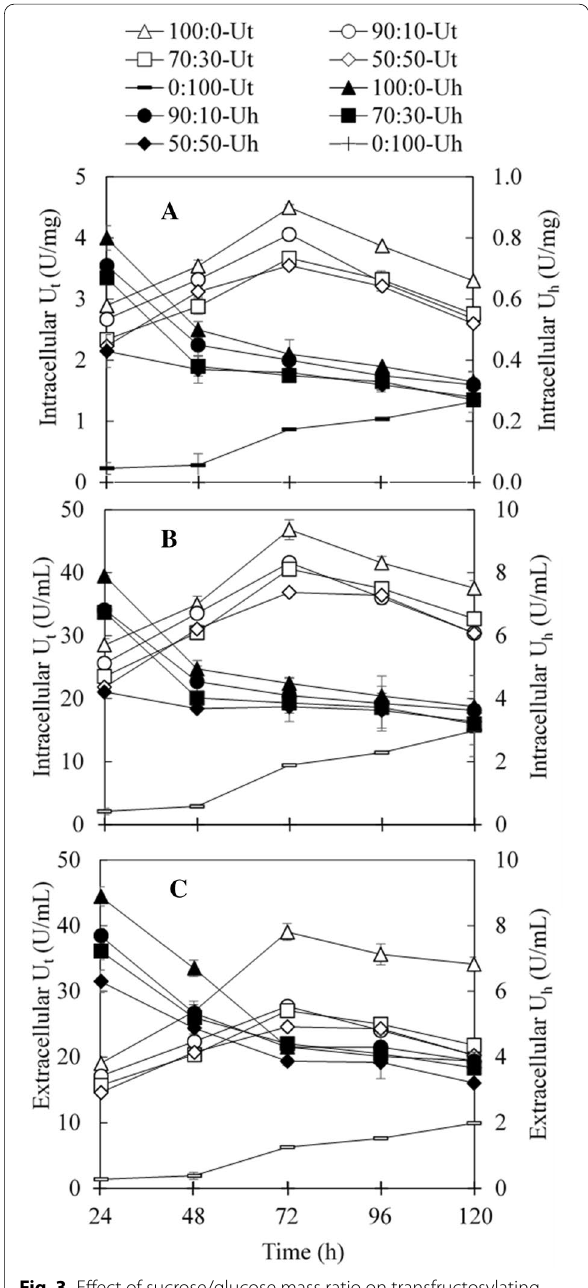
Fig. 3 Effect of sucrose/glucose mass ratio on transfructosylating enzyme production by A. pullulans FRR 5284. A Intracellular transfructosylating (U t ) and hydrolytic (U h ) activities based on cell mass; B intracellular U t and U h based on cultivation volume; C extracellular U t and U h based on cultivation